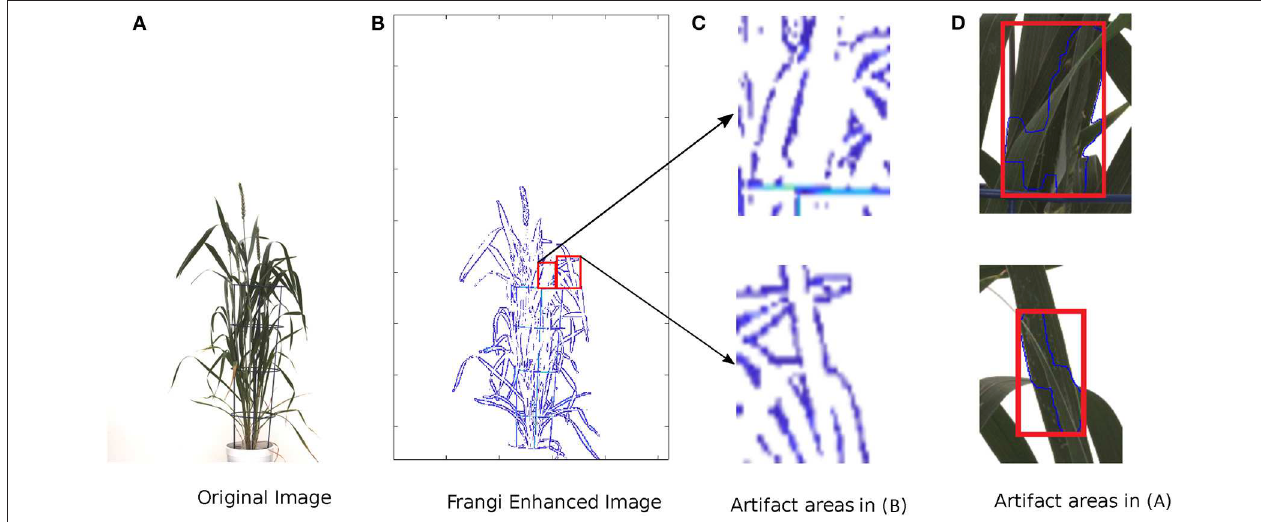
FIGURE 5 | Example of suppression of leaf crossings using the Frangi Filter. From left to right: (A) original image of a wheat shoot, (B) Frangi filter-enhanced image, (C) examples of Frangi-enhanced regions, (D) examples of leaf crossings detected in the original